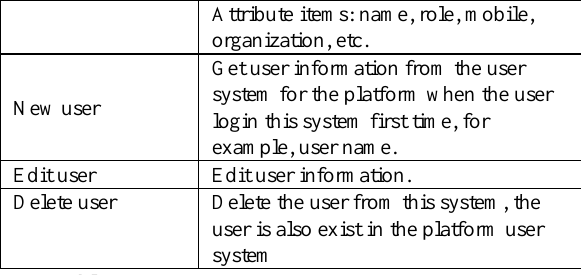
Table 7 . Function items in user management module